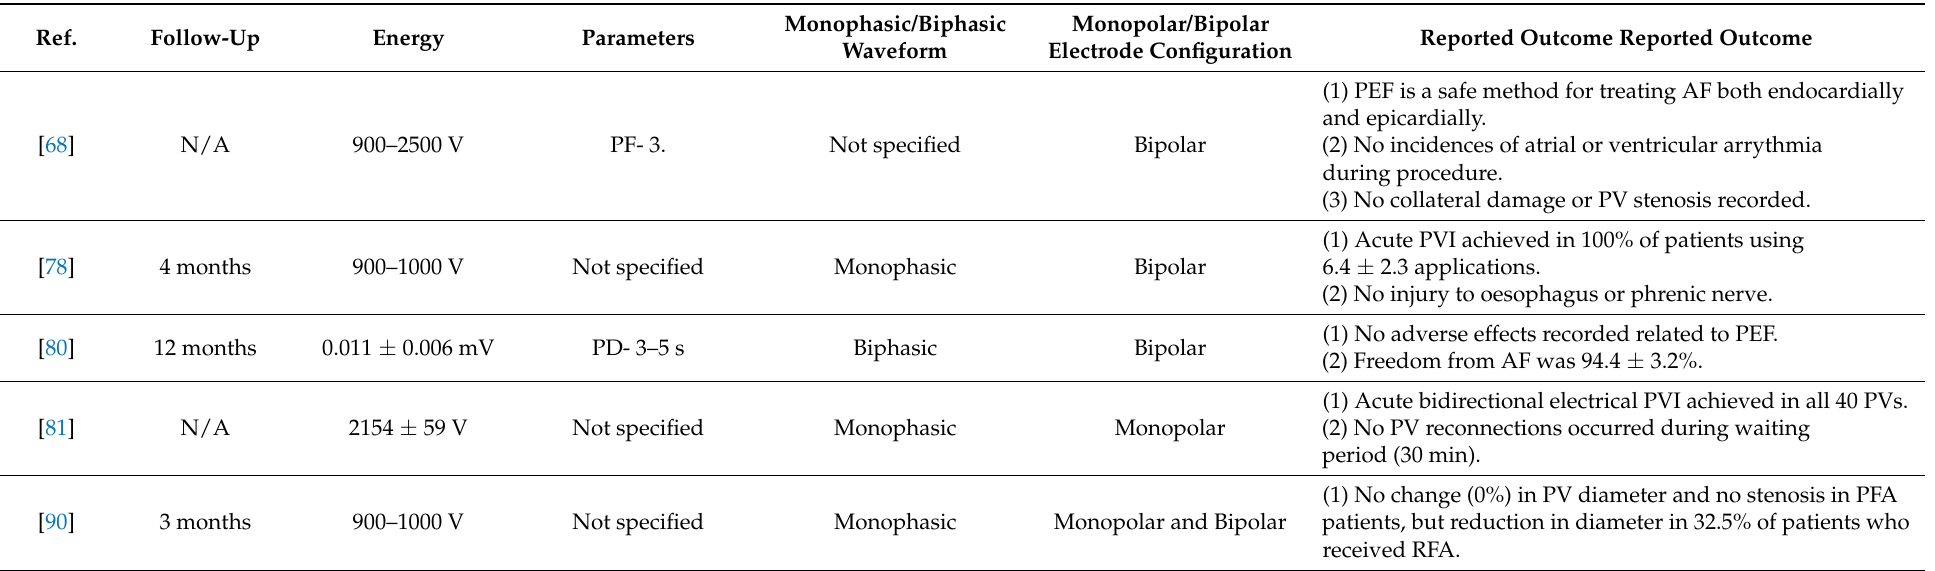
Table 1. Comparison of clinical IRE studies on cardiac